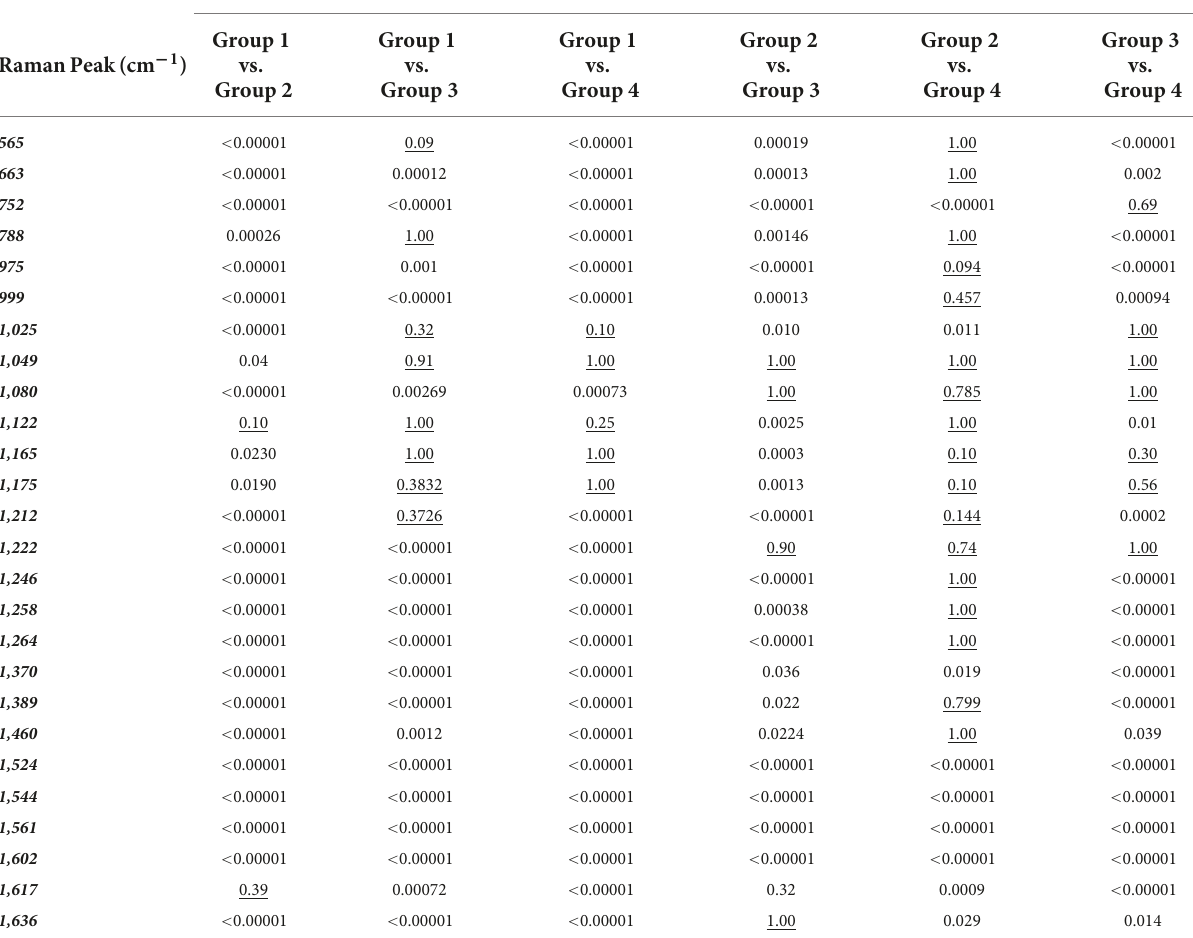
TABLE 2 Level of significance of the significantly different Raman peaks derived from pair-wise Wilcoxon post-hoc test between RBCs of healthy and the disease samples. RamanPeak(cm − 1 )